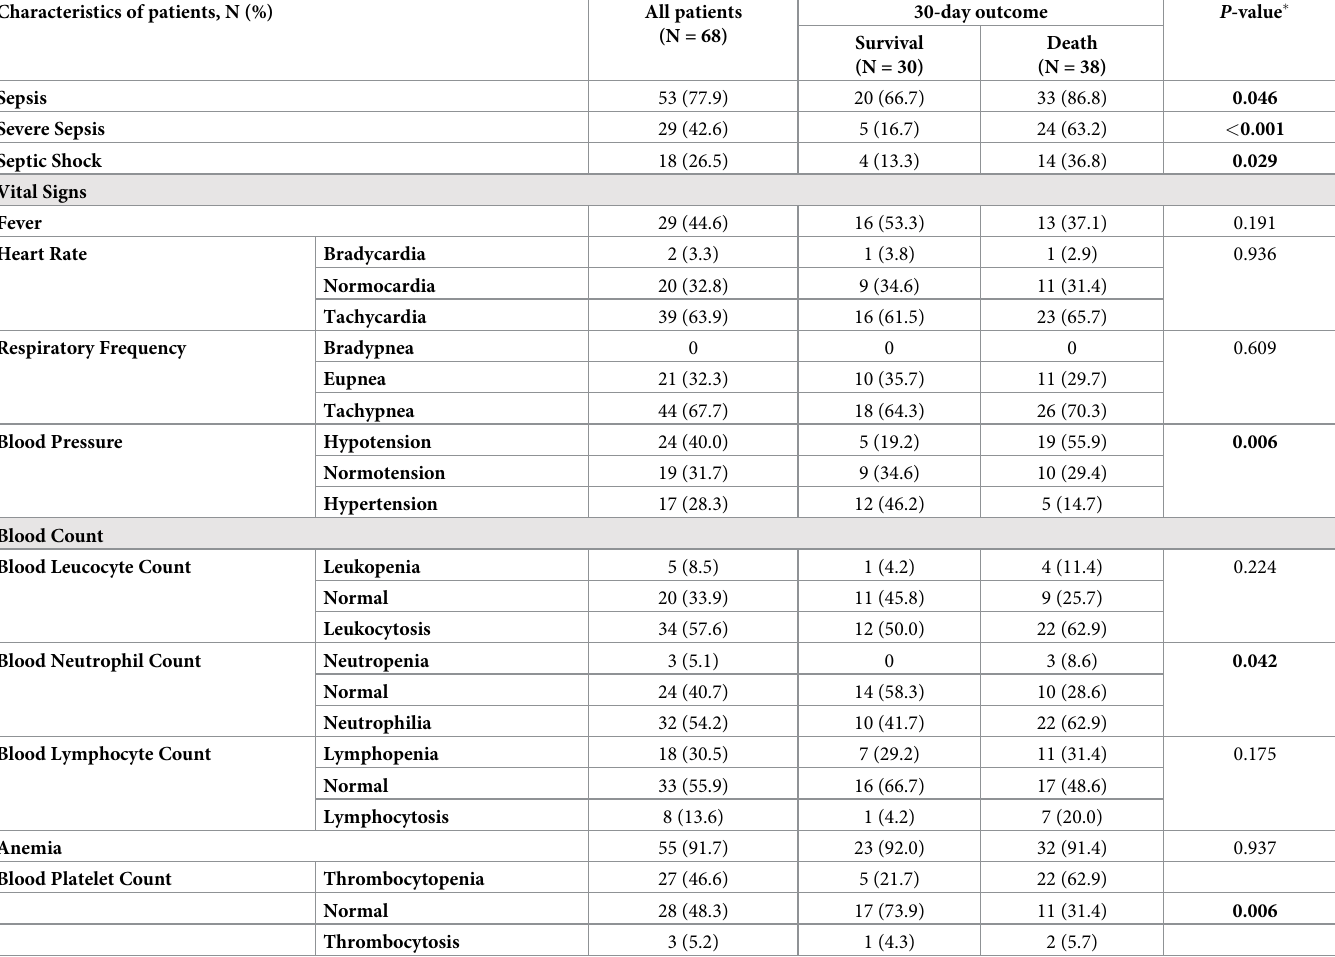
Table 2. Clinical condition of patients on candidemia onset, including comparison between subgroups according to the outcome. Characteristics of patients, N (%)